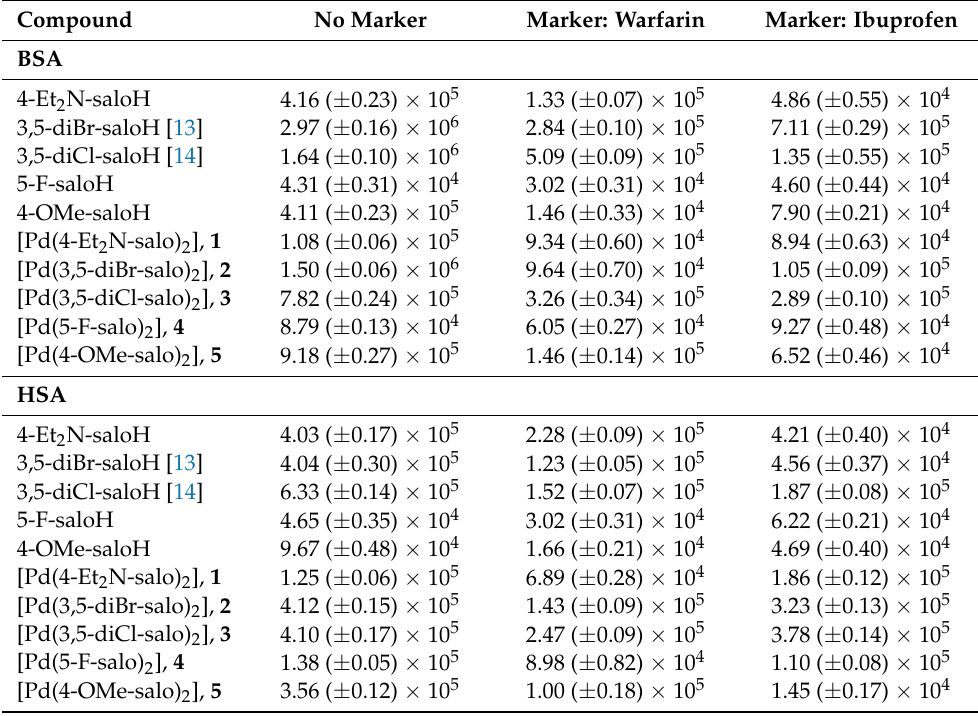
Table 6. BSA- and HSA-binding constants of the compounds (K, in M − 1 ) in the presence of the site probes warfarin and